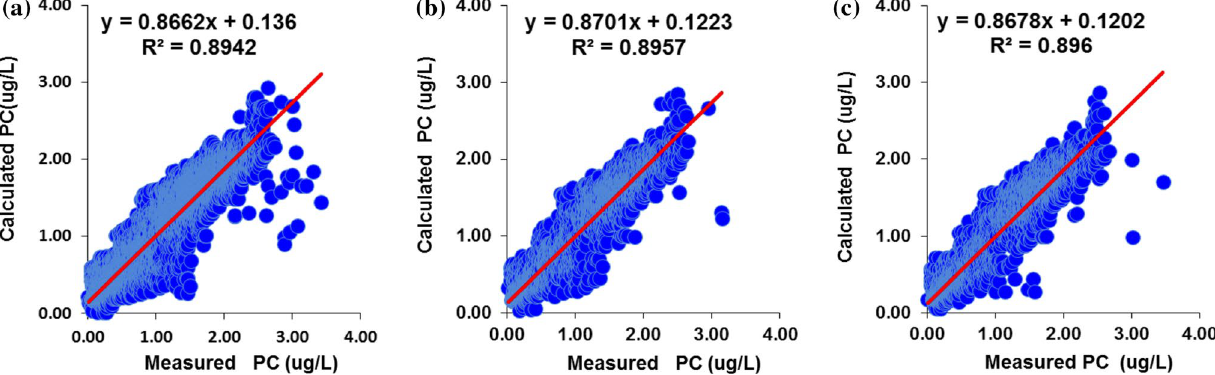
Fig. 4 Scatterplots of estimated versus measured values of PC for ANFIS_GP (M1) model: a training, b validation and c test data—Station